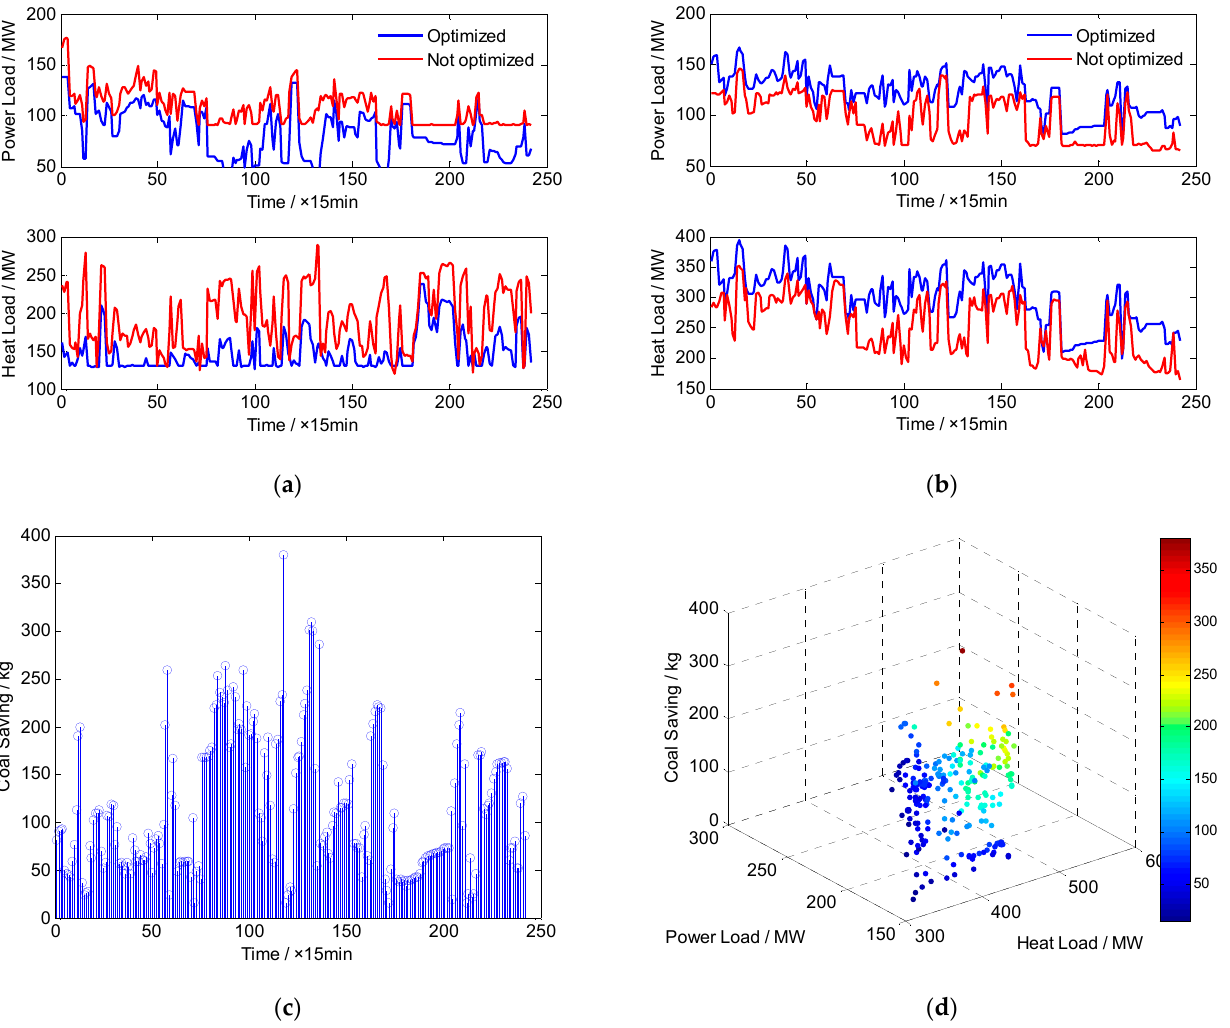
Figure 11. Comparison before and after optimization under mode 2 (HBP + LPCC) working condi- tions. ( a ) Electric and heat load of HBP unit. ( b ) Electric and heat load of EH unit. ( c ) Coal saving before and after optimization. ( d ) Spatial distribution of coal saving potential.